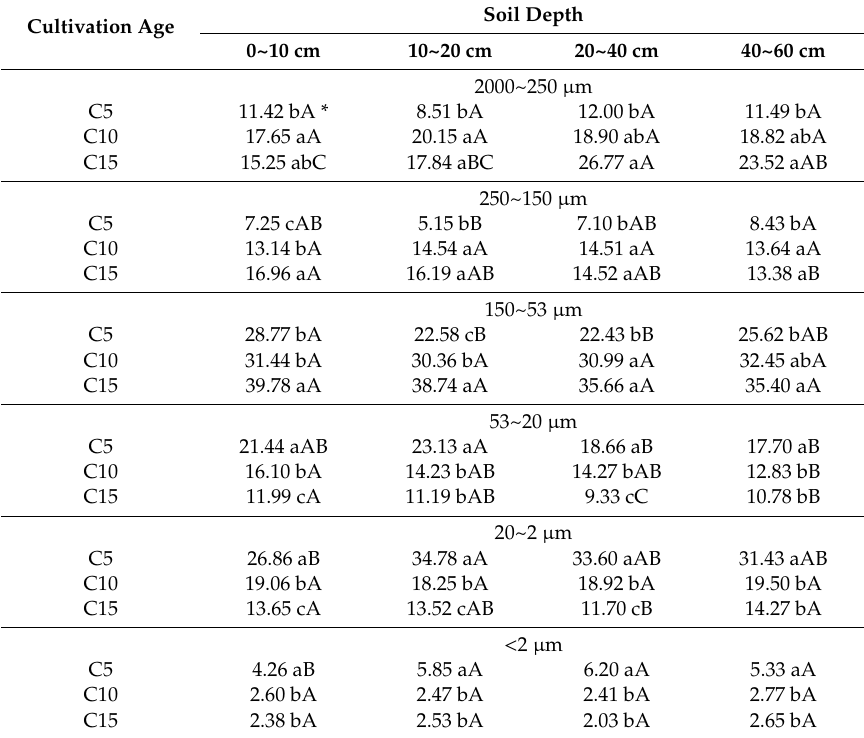
Table 2. The redistribution of soil particle sizes within soil layers under di ff erent cultivation